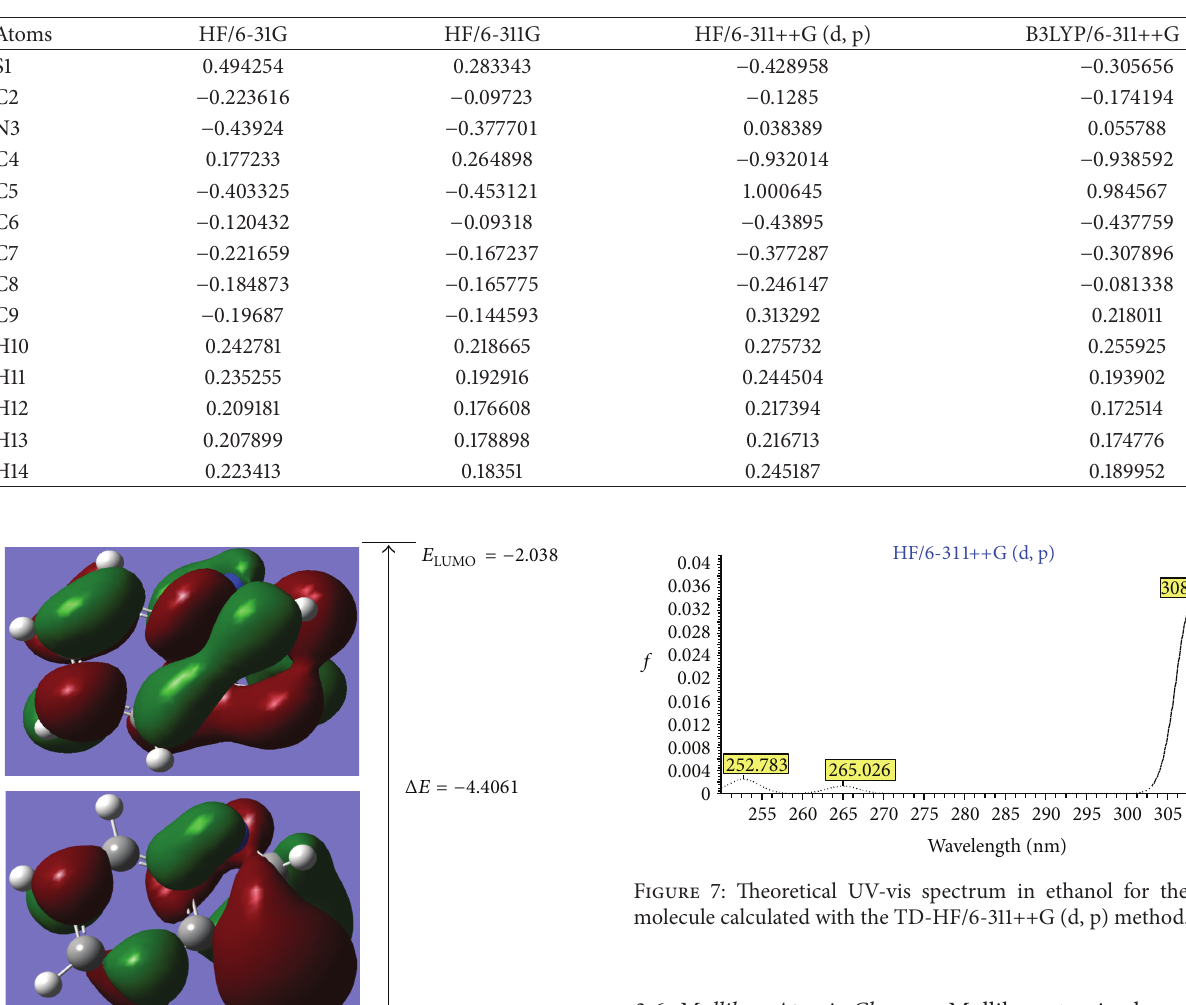
Table 8: Mulliken atomic charges of benzothiazole.